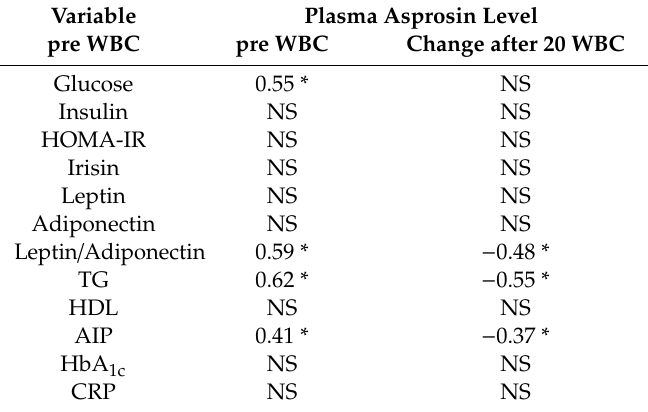
Table 5. Correlations between plasma asprosin and metabolic risk factors in all subjects. Variable Plasma Asprosin Level pre WBC pre WBC Change after 20 WBC Glucose 0.55 * NS Insulin NS NS HOMA-IR NS NS Irisin NS NS Leptin NS NS Adiponectin NS NS Leptin / Adiponectin 0.59 * − 0.48 * TG 0.62 * − 0.55 * HDL NS NS AIP 0.41 * − 0.37 * HbA 1c NS NS CRP NS